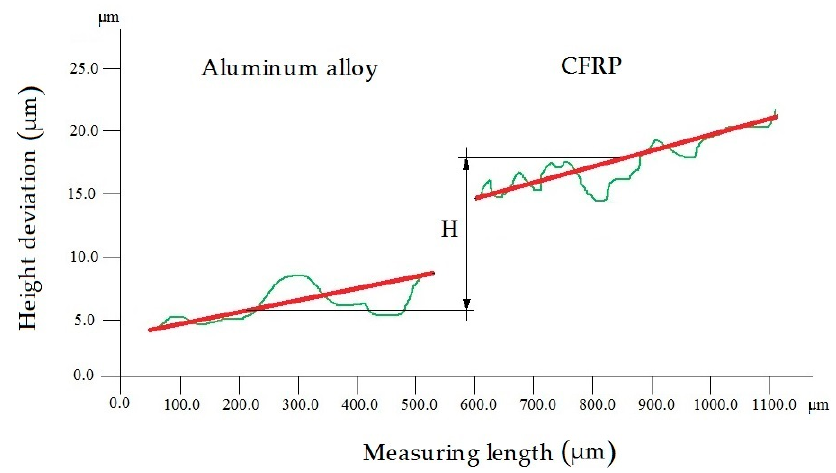
Figure 3. Height deviation of the Al/CFRP sandwich structure.